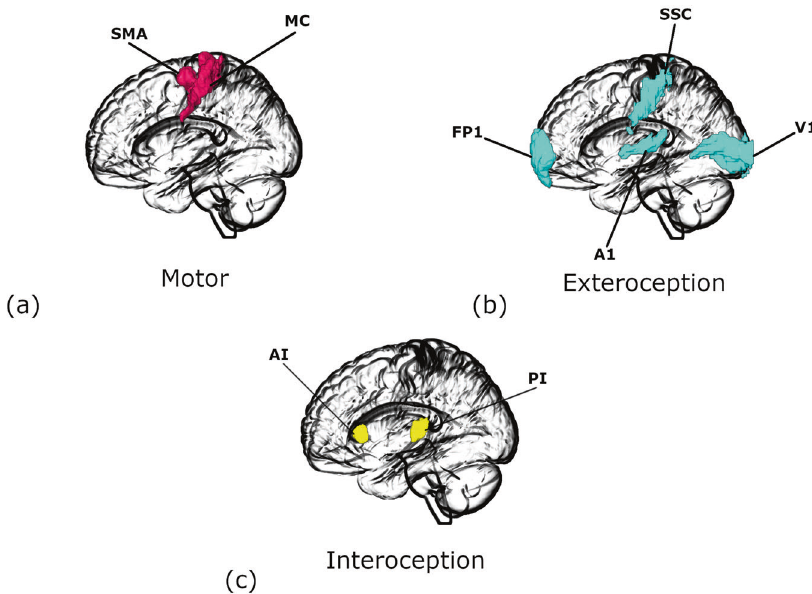
Fig. 2 Regions of interest for different networks. a Motor. b Exteroceptive, and c Interoceptive networks. FP1: lateral frontal pole, A1: primary auditory cortex, V1: primary visual cortex, SSC: primary somatosensory cortex, AI: anterior insula, PI: posterior insula, MC: primary motor cortex. SMA: supplementary motor area. The images were created using MRIcroGL